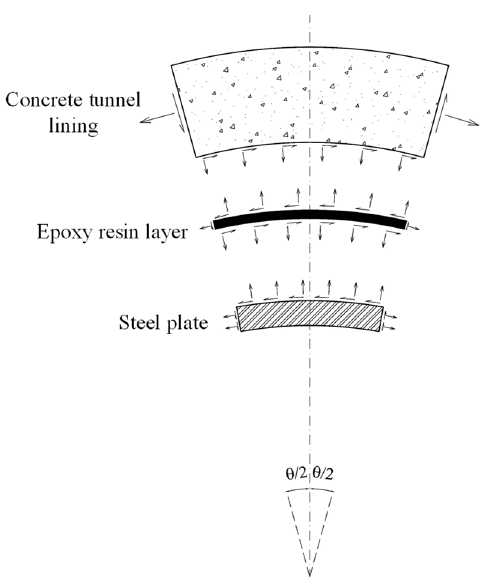
Figure 1. A sketch of a steel plate strengthened circular tunnel.